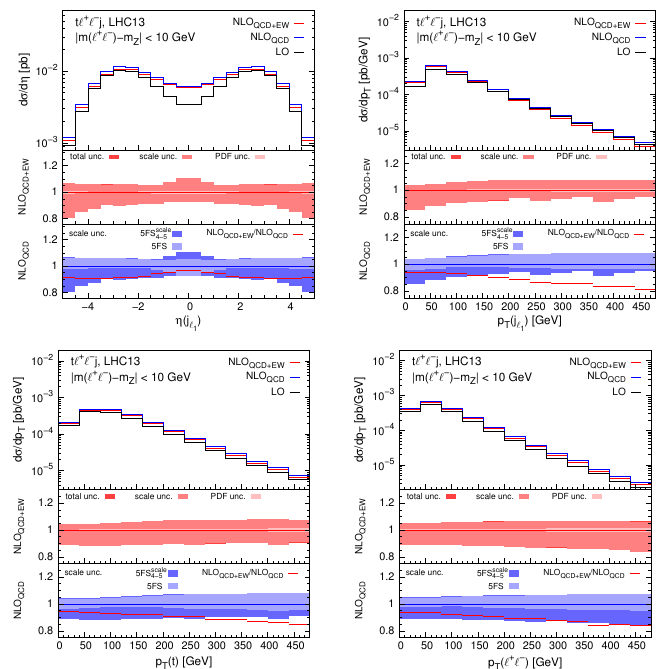
Figure 6 . NLO QCD+EW predictions for t‘ + ‘ (cid:0) j ( Z -peak). The layout of the plots is the same of (cid:12)gure